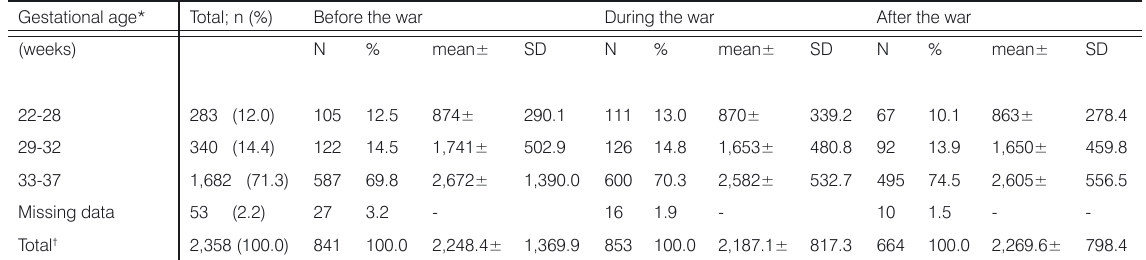
*Chi-square test of the difference among three periods in the number of births in each gestational age group: (22-28) - χ 2 =3.31,